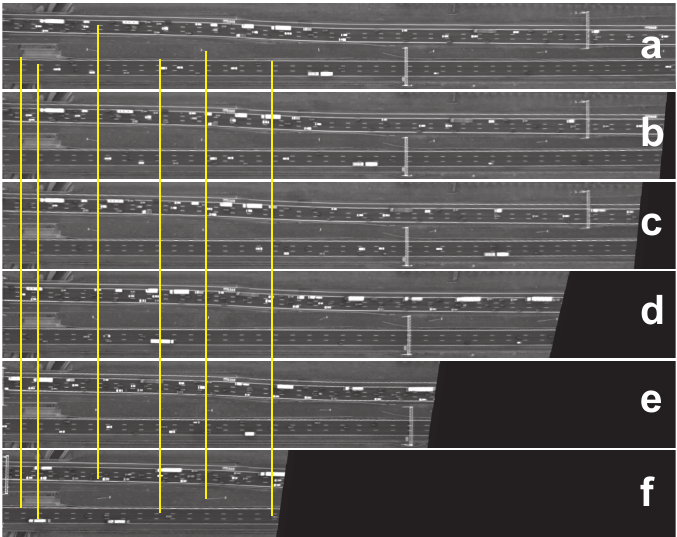
Figure 10. The red crosses indicate five manually-selected points ( left ). Points 1–3 are located outside the road plane, while Points 4 and 5 are located on the road